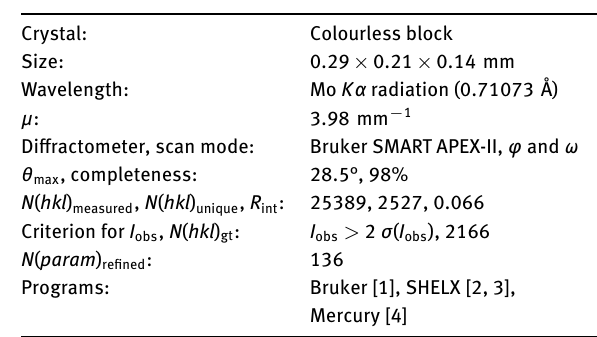
Table 1: Data collection and handling.